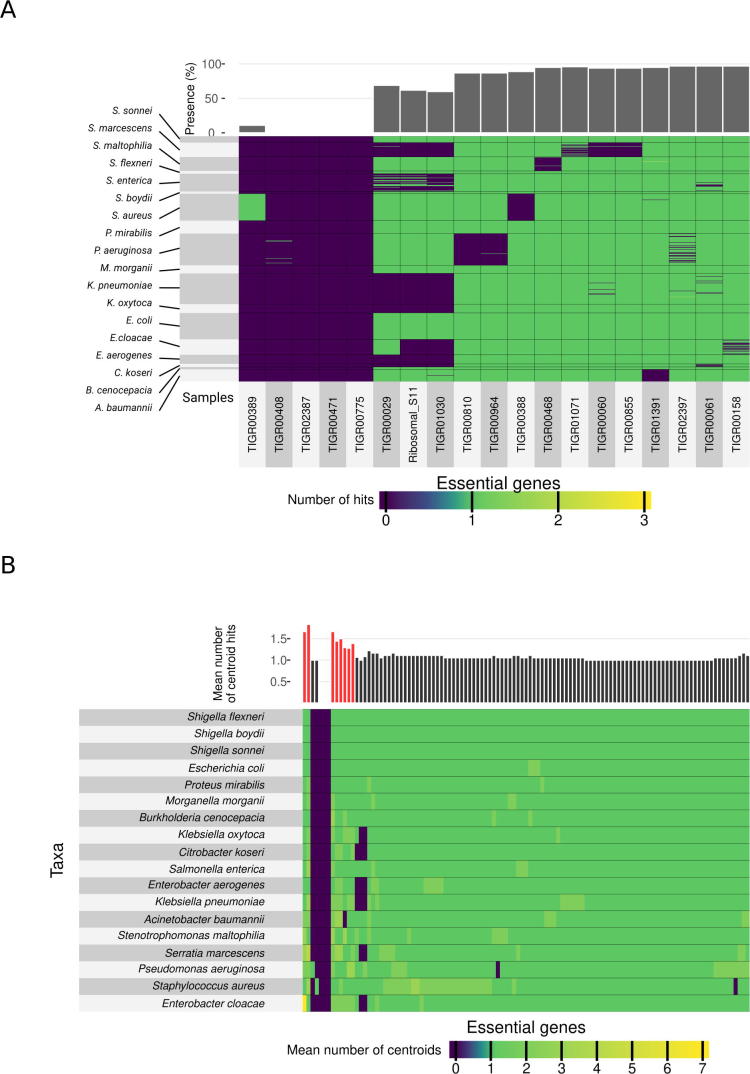
Essential gene hits per isolate and number of centroids covering essential genes A. Essential gene hits per isolate found in less than 99% of the isolates. The number of hits per isolate is coded in color gradient and the isolates were grouped by species. The bar plot at the top of the heatmap shows the frequency of the essential genes over all isolates. B. Mean number of centroids containing genes matched to essential genes per species. The bar plot shows the mean across all species and bars representing the mean number larger than 1.25 are highlighted in red.